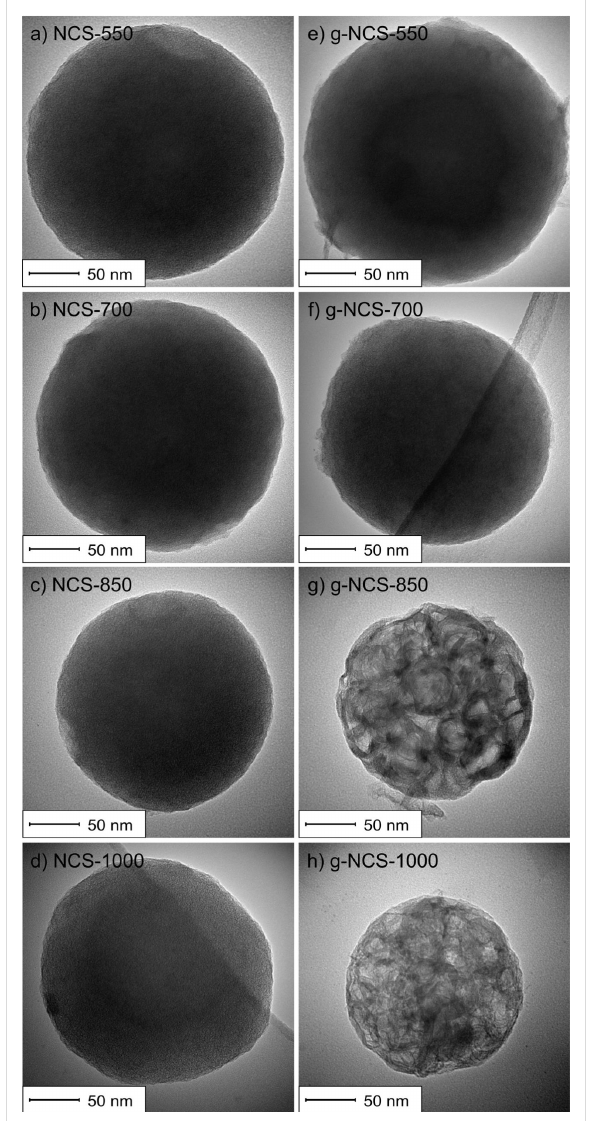
Figure 3: TEM images of (a–d) the NCS catalysts and (e–h) the g-NCS catalysts. The TEM images in (a–d) are reprinted with permis- sion from [27], copyright 2019